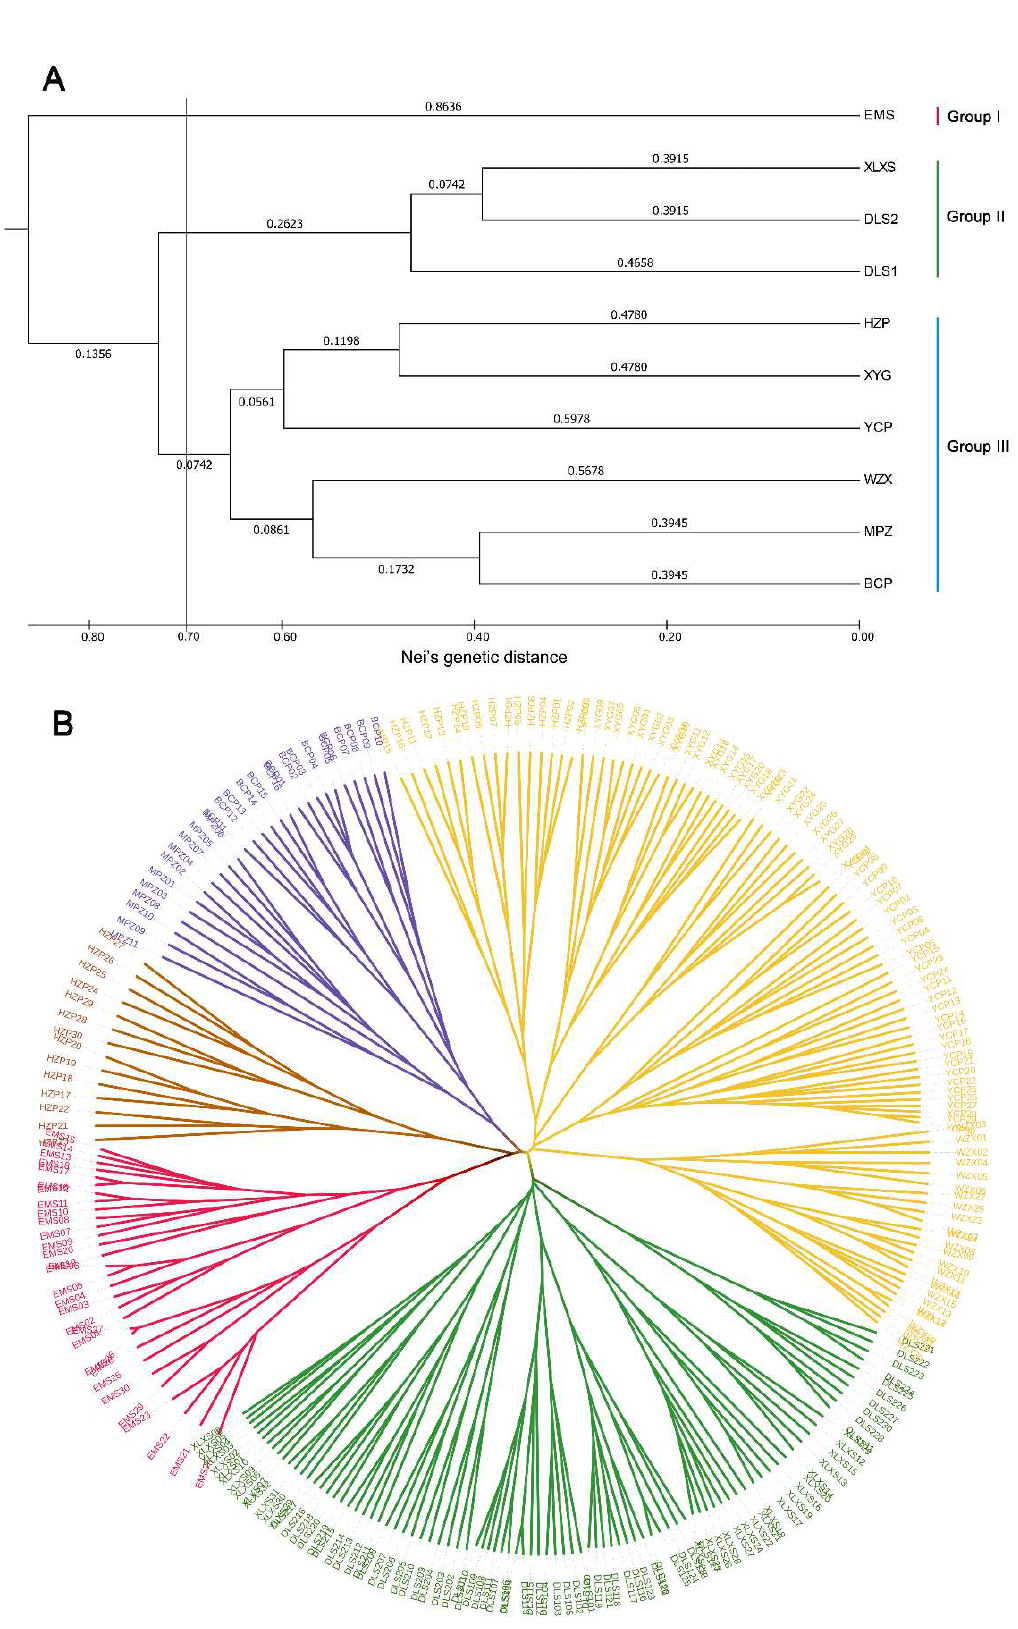
Figure 2. Genetic divergence of O. serrulatus based on UPGMA cluster analysis. ( A ) Clustering among ten populations; ( B ) clustering among 262 individuals.